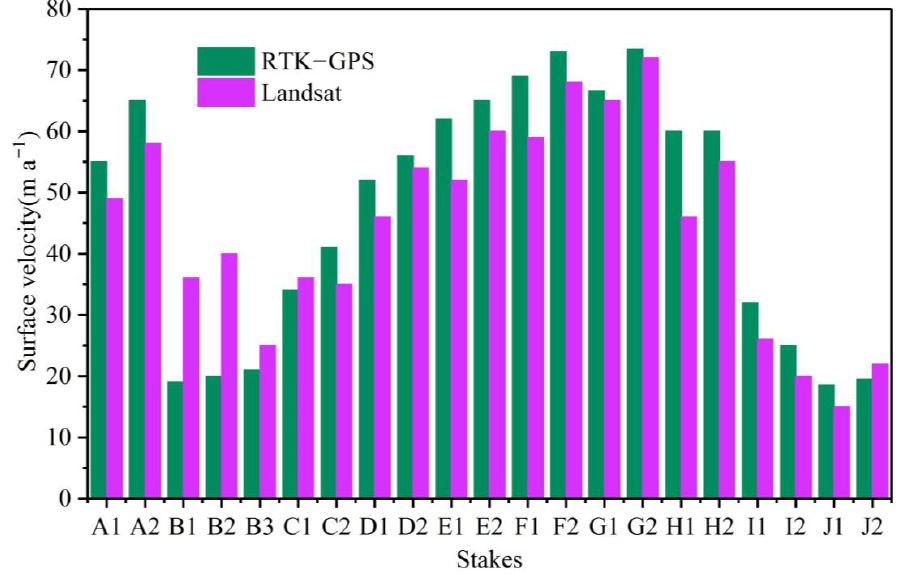
Figure 6. Comparison of RTK − GPS observed data and calculated remote sensing inversion data for the Qingbingtan No. 72 glacier.